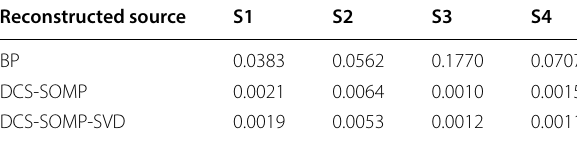
The source maps obtained by the wideband BP method, the DCS-SOMP method, and the DCS-SOMP-SVD method at different SNRs are shown in Figure 5, Fig- ure 6, and Figure 7. When the SNR equals 0 dB, the DCS- SOMP-SVD method can locate the whole sources exactly, while the wideband BP method can only locate three sources, and the DCS-SOMP method has 1 grid error in locating sources. Besides, the max OASPL error of DCS- SOMP-SVD method among the whole sources being 0.0041% is less than the max OASPL error of the wide- band BP method being 10.6171% and the max OASPL error of DCS-SOMP method being 1.4726%. As the SNR